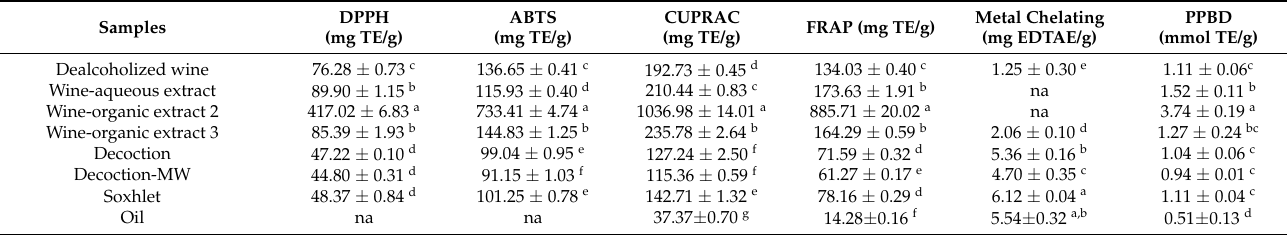
Table 4. Antioxidant properties of wine, grape skin extracts, and oil.